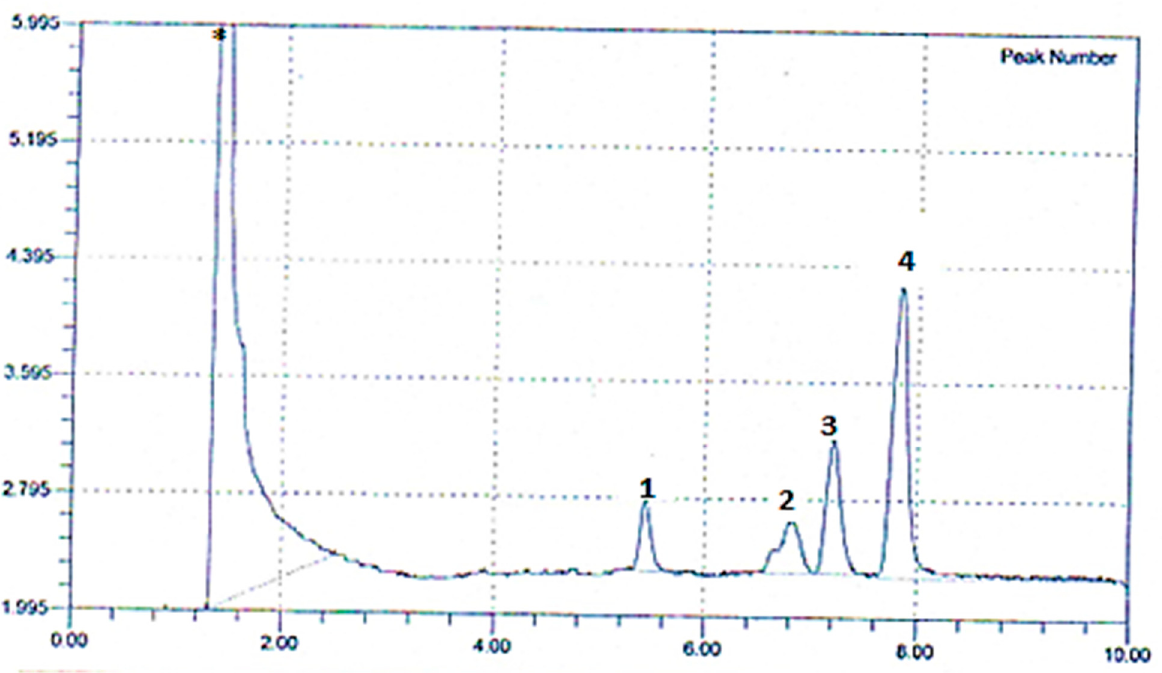
Figure 16. Barthenosteriode at 10 mL/L GLC. (* is the solvent, 1 is the palmitic acid, 2 is oleic acid, 3 is a Linoleic acid and 4 is the α - α linolenic acid) of chia ( Salvia hispanica L.) fixed oil content as impacted by various bio-stimulating materials. Figure 17. Algae at 2 mL/L GLC (* is the solvent, 1 is the palmitic acid, 2 is oleic acid, 3 is a Linoleic acid and 4 is the α - α linolenic acid ) of chia ( Salvia hispanica L.) fixed oil content as impacted by various bio-stimulating materials.